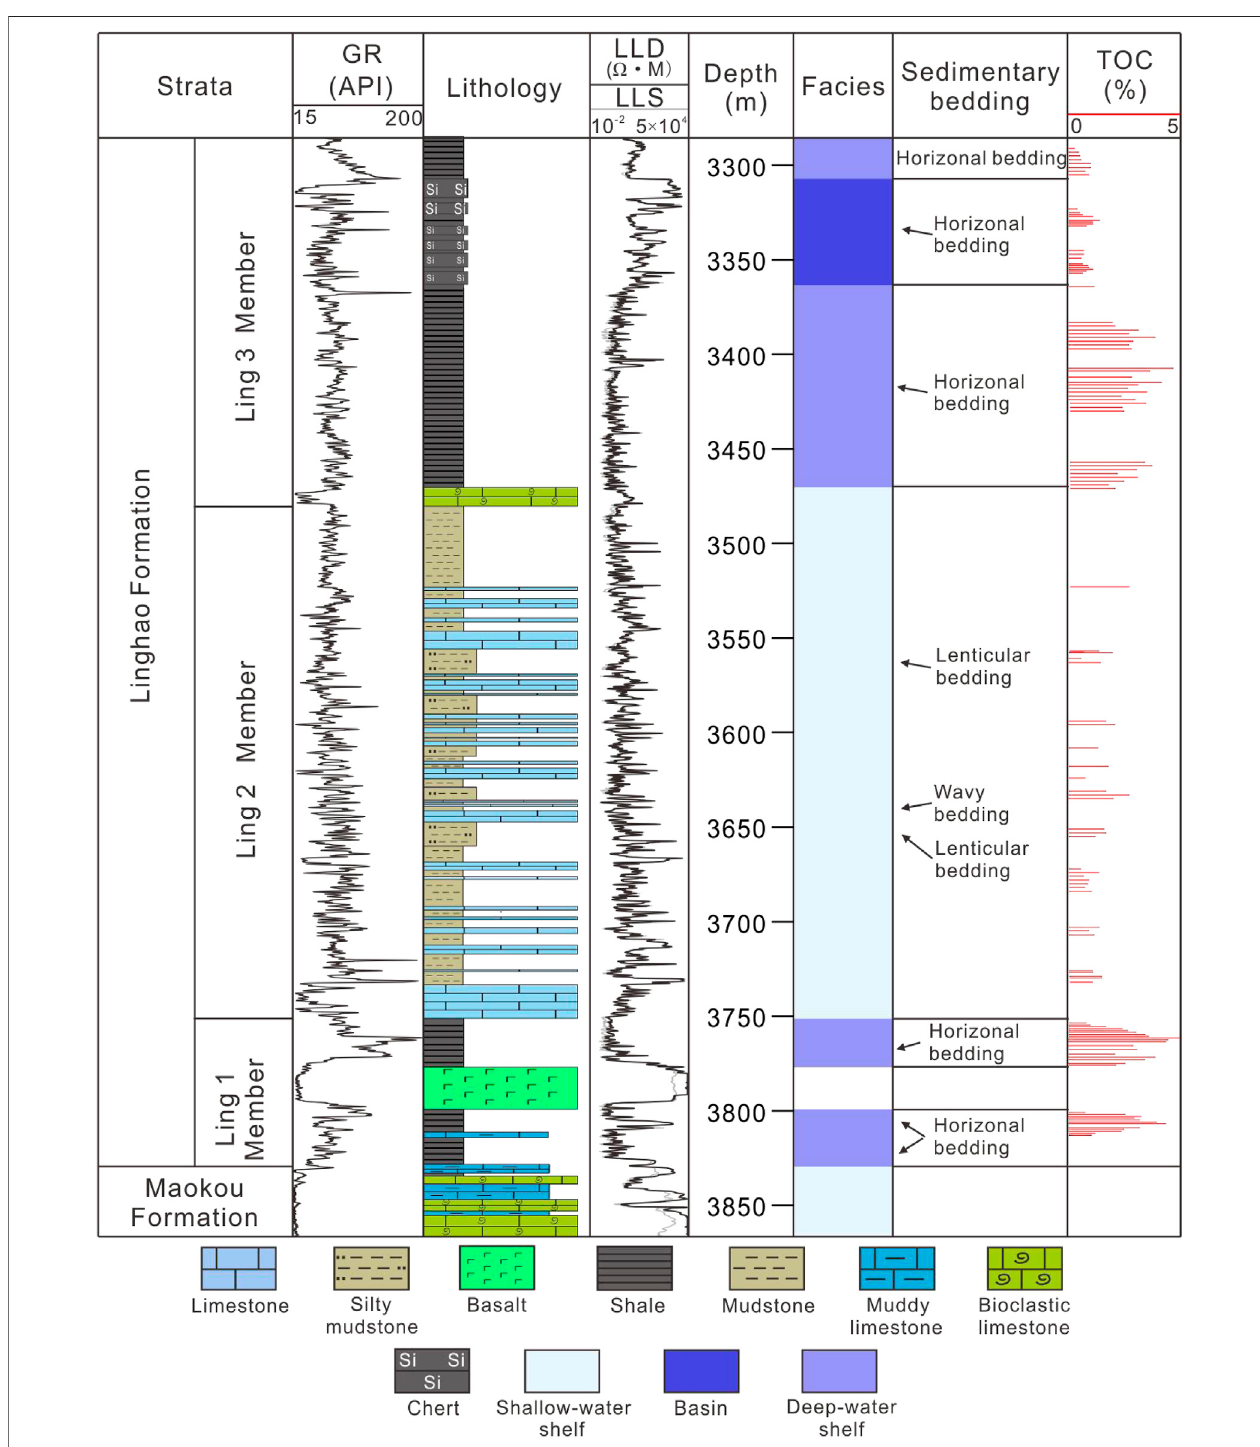
FIGURE 5 | Comprehensive histogram of sedimentary facies of Linghao Formation marine shale from the studied well in the central Nanpanjiang basin.